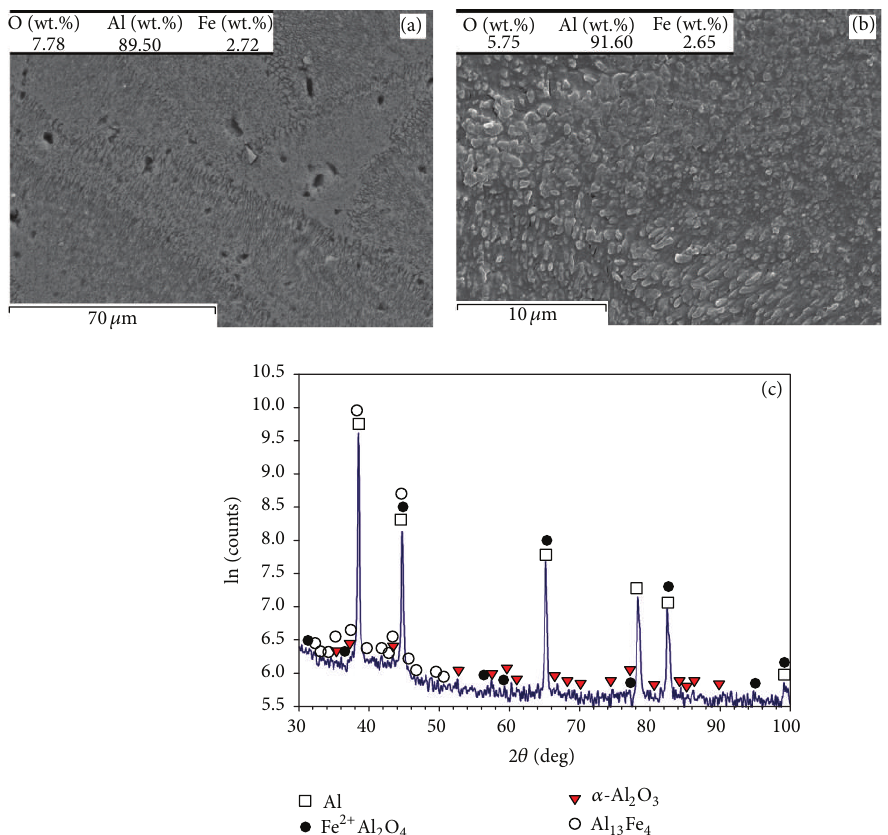
Figure 9: (a) Grain structure, (b) fine particles formed inside grains and boundaries (closeup of the previous image), and (c) XRD pattern of the part made by 𝑃 = 91 W, V = 0.14 m/s, and 𝑡 = 50𝜇